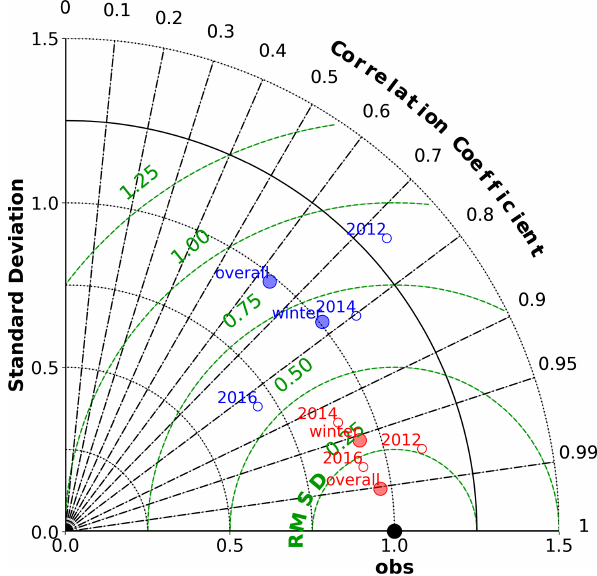
Figure 2. Taylor diagram of simulated and measured temperature (red) and salinity (blue) along the Ferrybox transect from Tallinn to Helsinki. Overall – all available observations from 1 November 2011 to 1 June 2016 (filled circles); winter – all available observa- tions from December to the end of March, 2011–2016 (filled cir- cles) and winter observations from January–March in 2012, 2014, and 2016 (open